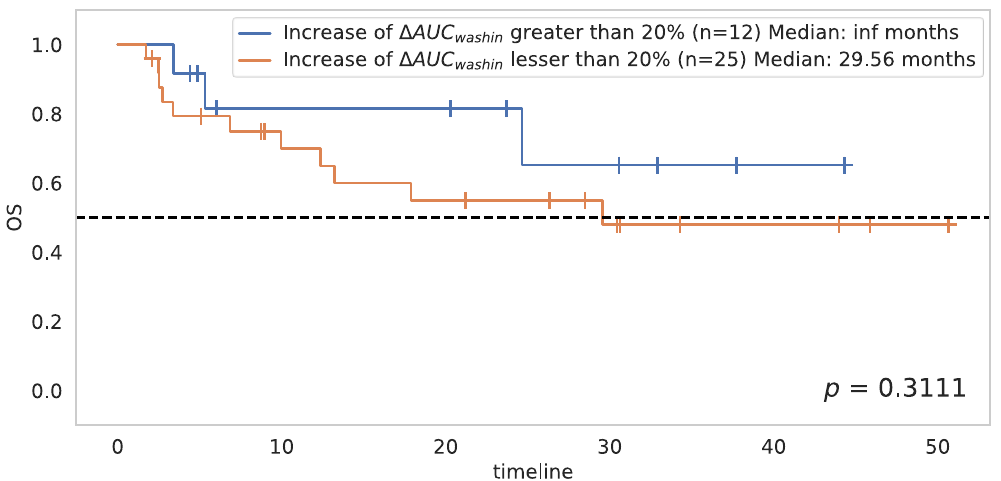
Figure 3. Impact of the overall survival of increase in AUC wash in from baseline to D8 greater than